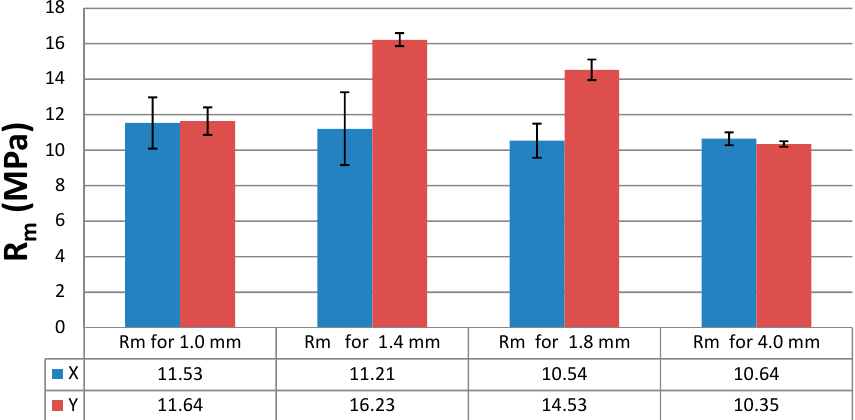
Figure 13. Tensile strength, Rm, of the PLA + bronze specimens, according to their thickness and the printing direction.